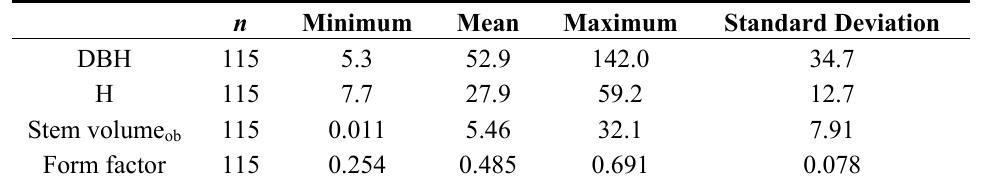
Table 4. Sample size ( n ) and dimensions of biomass trees with stem sectional measurements suitable for developing volume/taper functions.